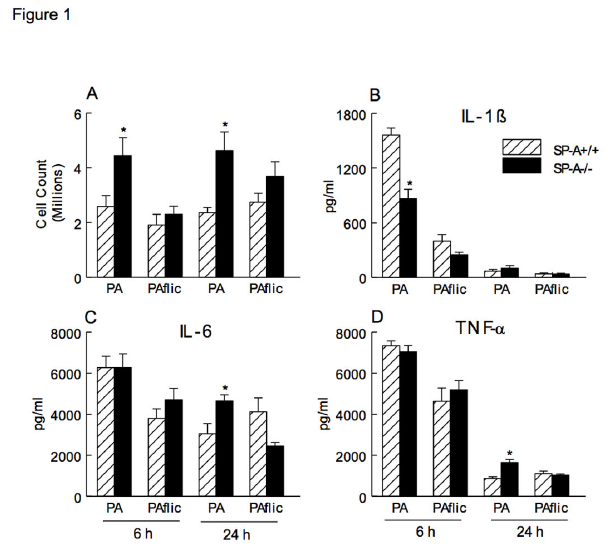
Figure 1. Increased total cell counts and pro-inflammatory cytokines in BAL fluid from SP-A -/- mice. Lung cells were recovered by BAL, stained with trypan blue and counted under light microscopy. Total cell counts were increased in the lung of SP-A-/- (closed bar) compared to SP-A+/+ (hatched bar) mice 6 (left panels) and 24 hours (right panels) following intra- tracheal infection with PAK. In contrast, total cell counts in the lung were similar between SP-A-/- and SP-A+/+ mice infected with fliC (A). IL-1β was decreased in the lung of SP-A-/- mice 6 hours following PAK infection and no difference was observed in IL-1β between SP-A-/- and SP-A+/+ mice following fliC infection (B). IL-6 and TNF-α were increased in the lung of SP- A-/- mice at 24 hours with PA infection, however there was no statistical difference in IL-6 or TNF-α between SP-A-/- and SP- A+/+ mice following infection with fliC (C, D). Data are mean ± SEM with n = 8 mice per group combined from 2 or more experiments, *p<0.05 compared to SP-A+/+